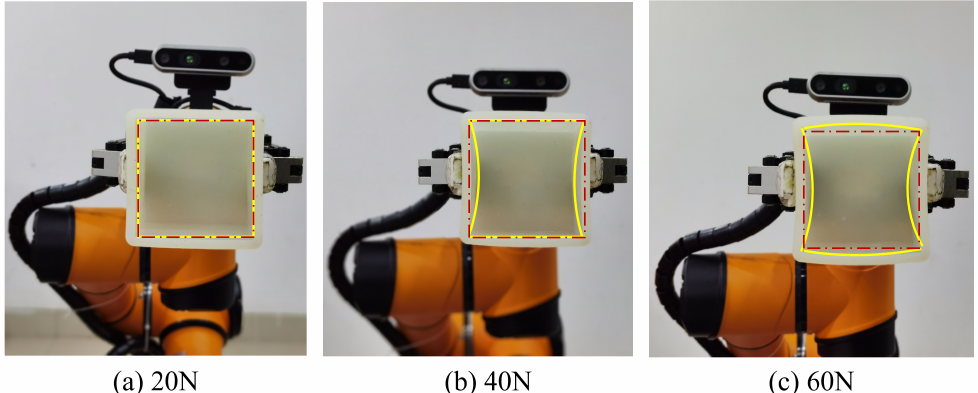
Figure 11. These figures show the deformation of the soft cubic box under different holding forces using the DH-Ag95 gripper. The degree of closure was fixed to 30% (28.5 mm in total and 14.25 on one side) during the test. The yellow lines represent the deformation of the box under different forces, and the red dot lines express the deformation of the box under 20% of maximum